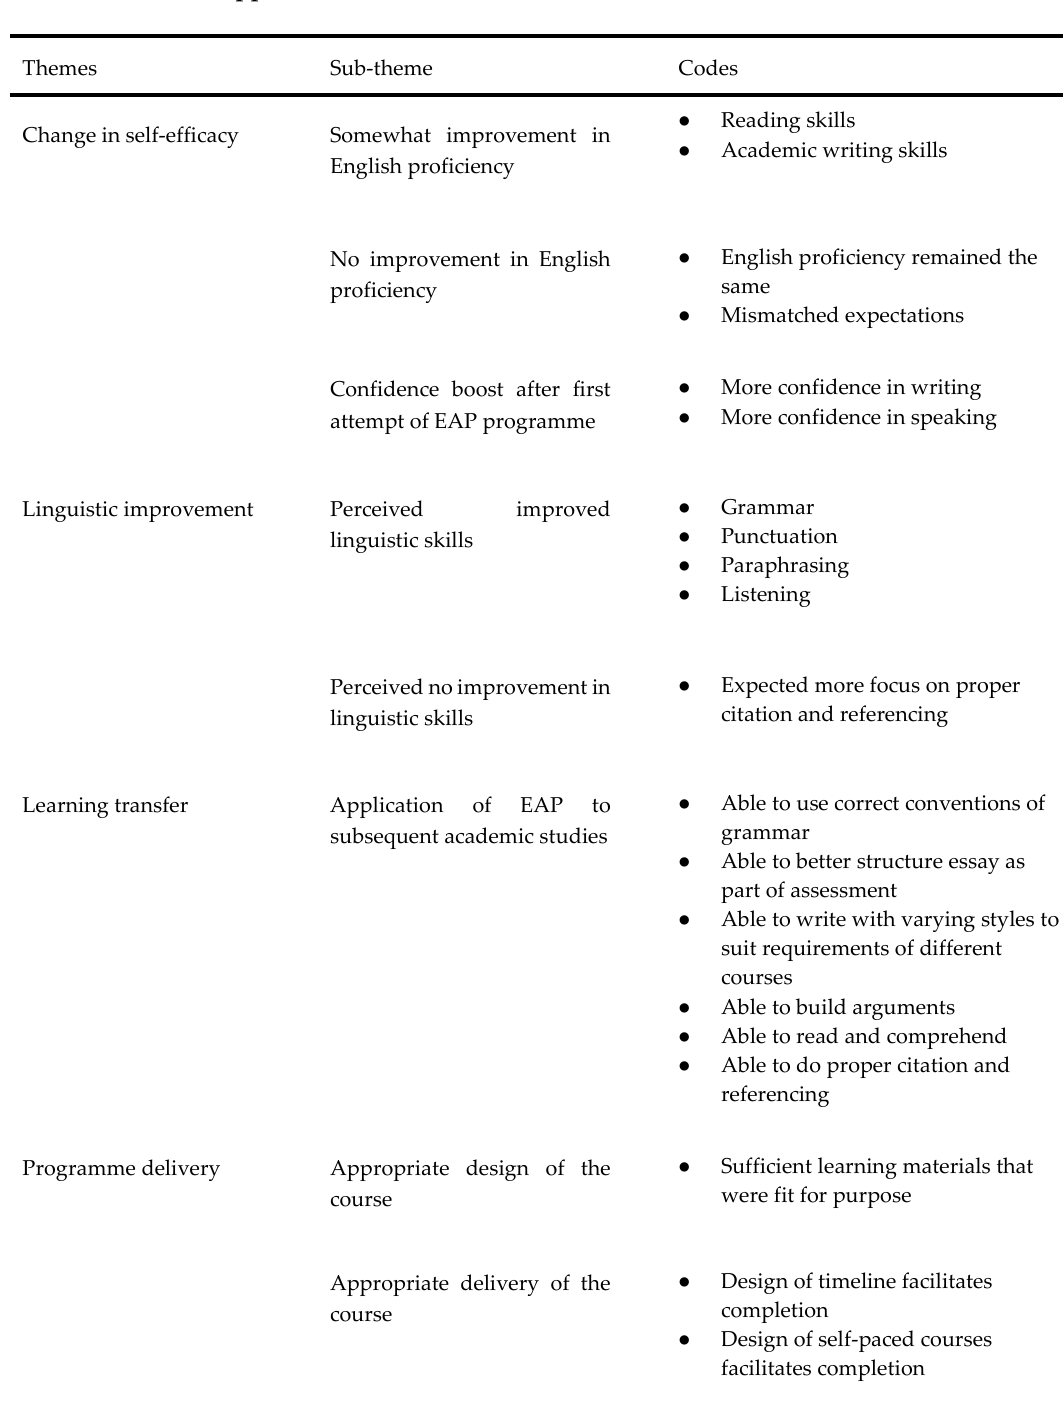
Figure A1. Summary of themes, sub-themes, and Figure A2. Summary of themes, sub-themes, and codes.